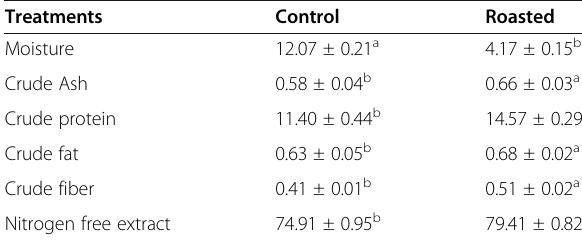
Table 1 Chemical composition of control (unroasted) and roasted fox nuts (% dry basis) Treatments Control Roasted